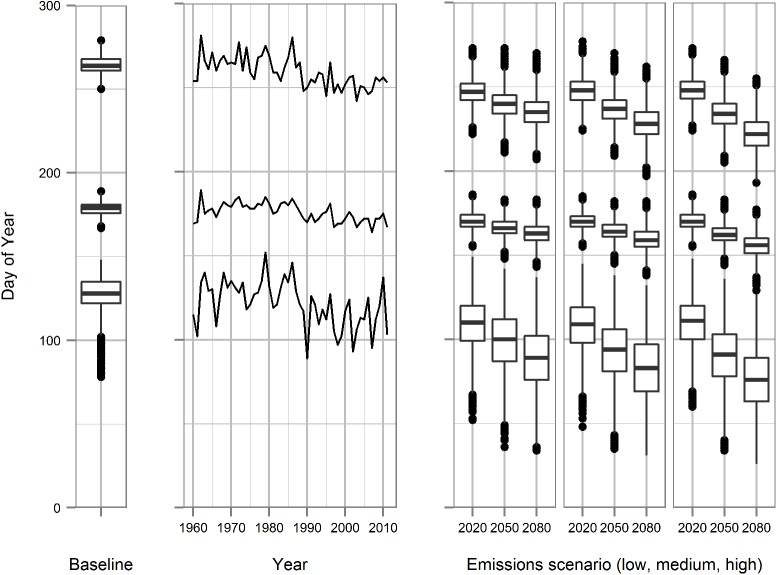
Modelled times of budbreak, flowering and veraison (from bottom to top) calculated from baseline (1960–90) weather generator runs, daily observed weather (1960–2011) and future climate weather generator runs using three emissions scenarios (low, middle and high emissions from left to right) and time periods.